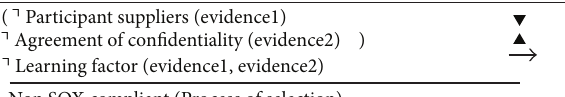
Figure 8: Suppliers Selection Process. Deductive Decision Making Protocol, Complementary